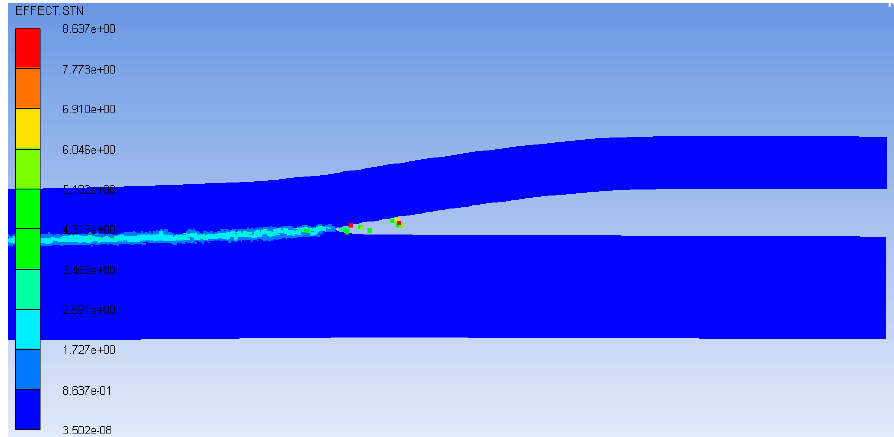
Figure 8. The contour of effective plastic strain distribution.